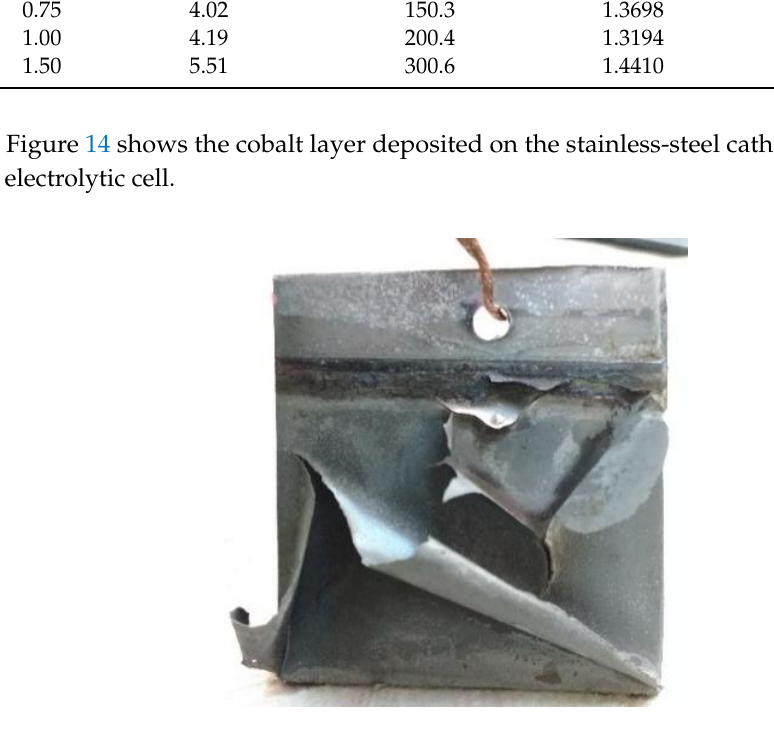
Figure 14. Cobalt deposited in the cathode.